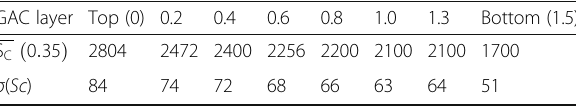
S C mean of spatial concentration values for five independent experiments and σ ( Sc ) standard deviation